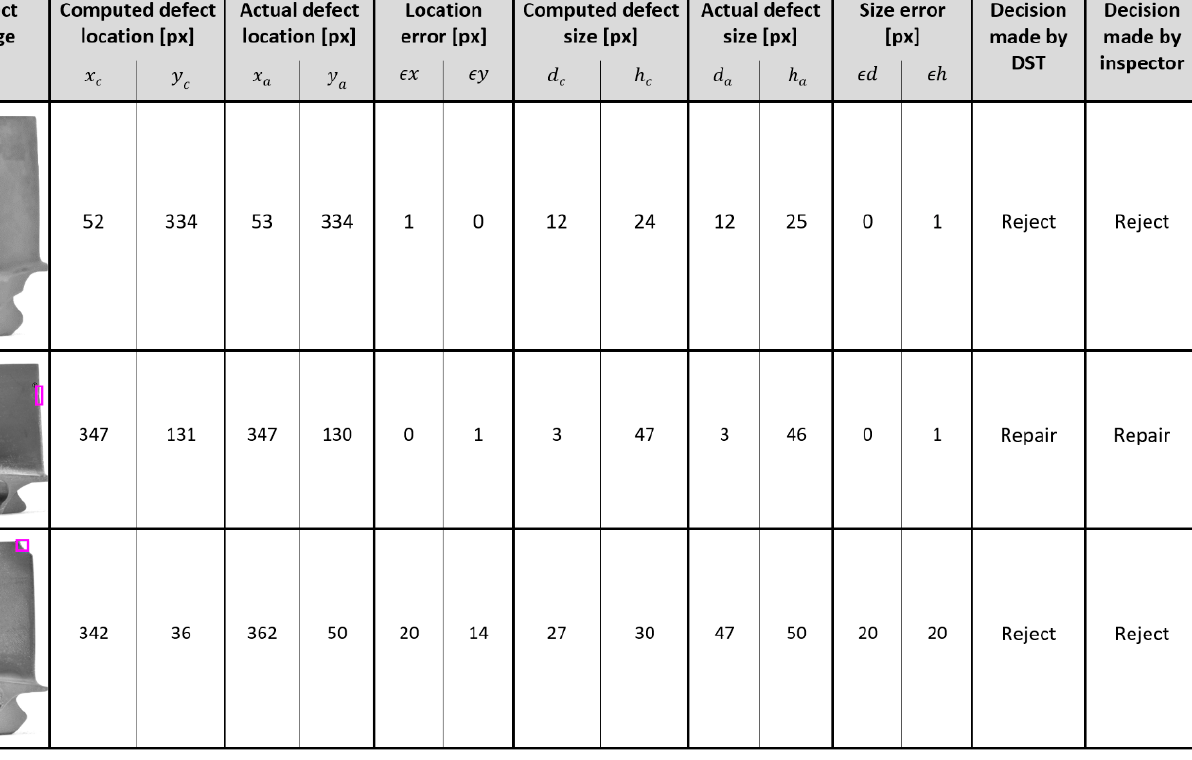
Figure 17. Overview of computed and actual defect characteristics, and comparison of maintenance recommendations (more samples are presented in Figure A1 in Appendix A).